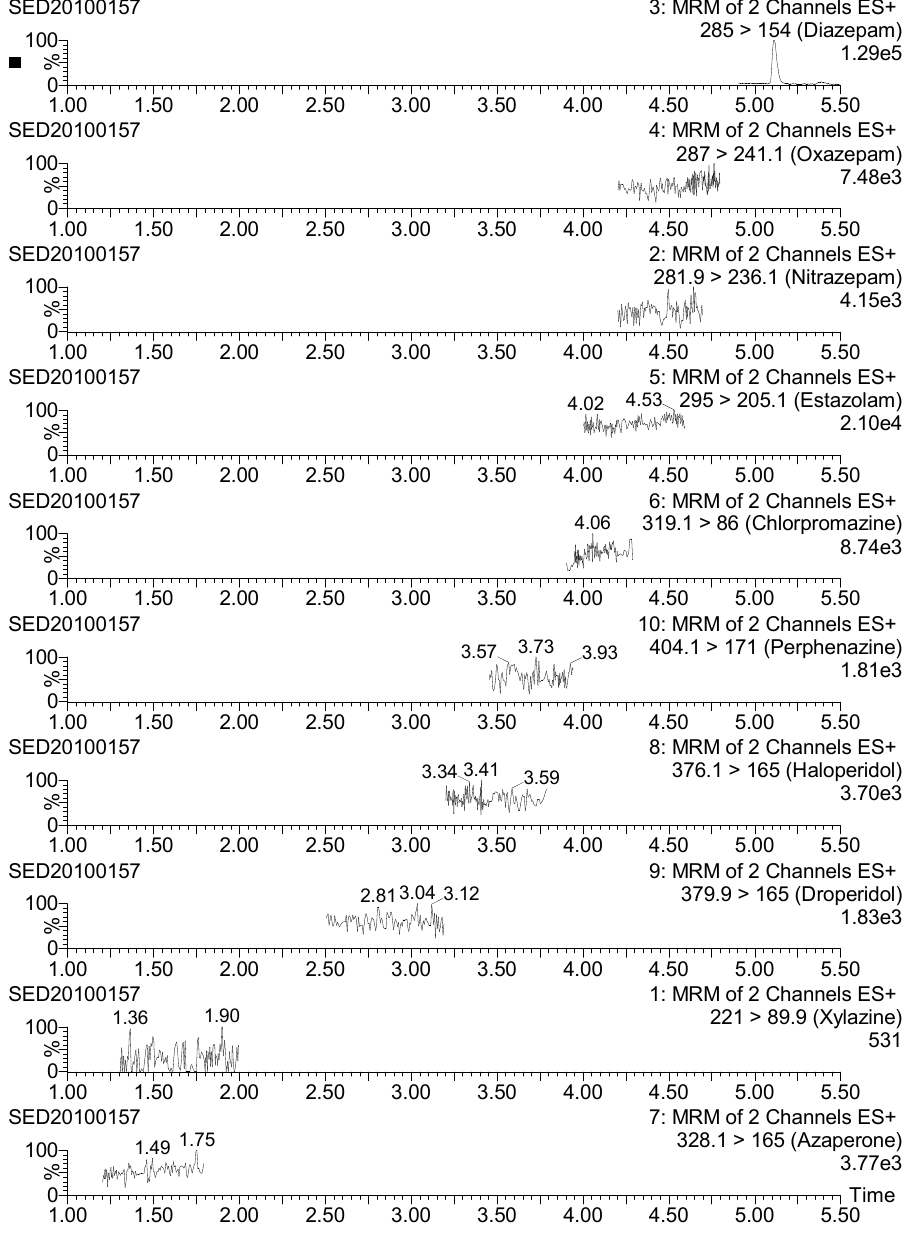
Figure 5. UHPLC-MS/MS chromatograms of a positive urine sample.